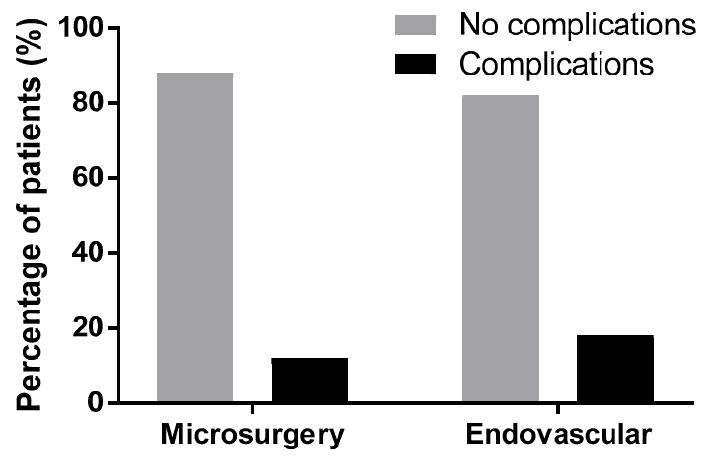
Figure 4. Statistical evaluation of complications in both modalities was not significant ( p = 0.322); Glasgow Outcome Score after three months.